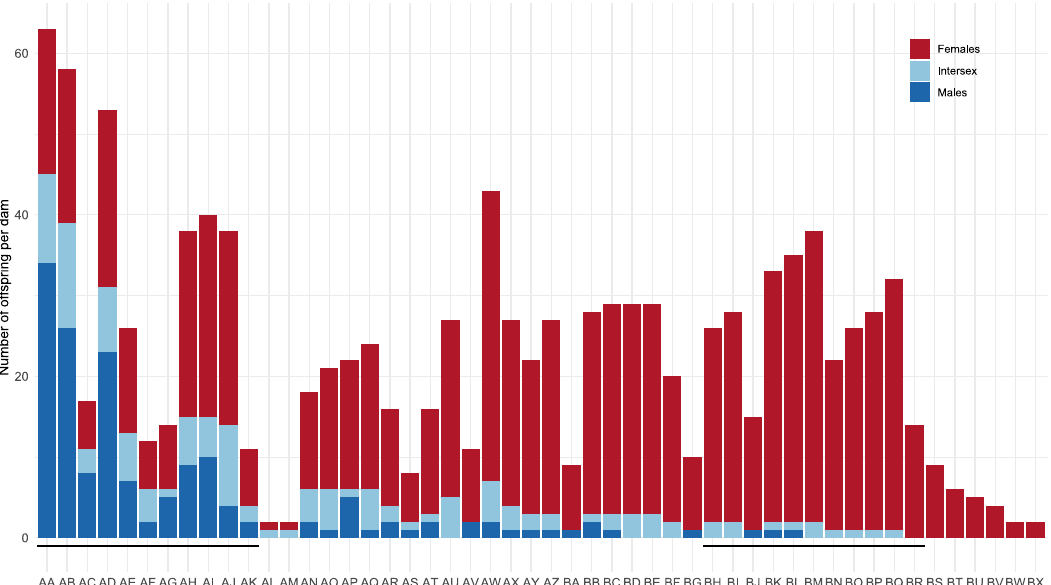
Figure 1. Total number of genotyped offspring (females, males and intersex) for each of the 50 dams (AA to BX) used in the mating design. The 22 dams with more than 10 genotyped offspring and extreme masculinisation rate selected for in-depth analysis of their genotypes are identified by a black underlying line.